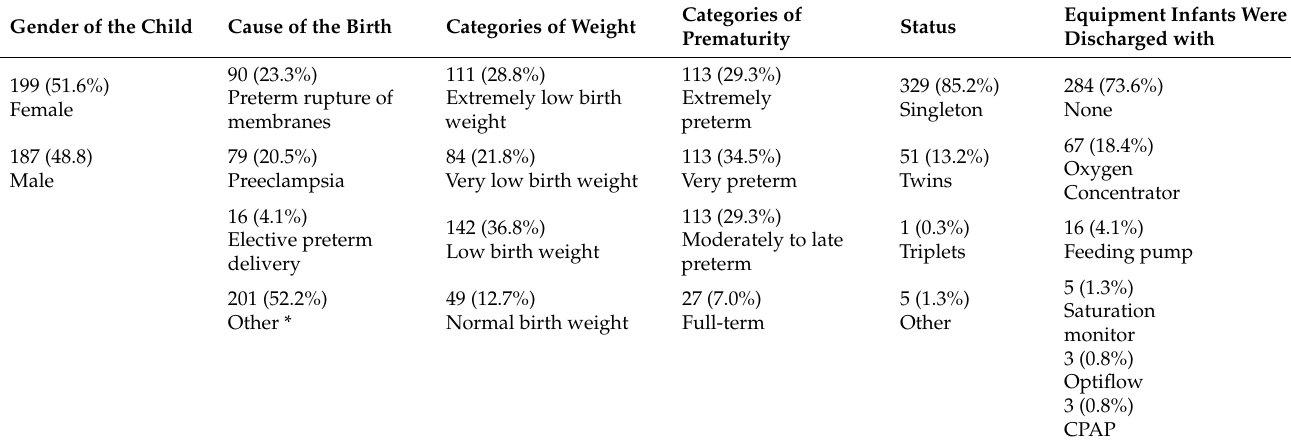
Table 2. Infant sample characteristics.